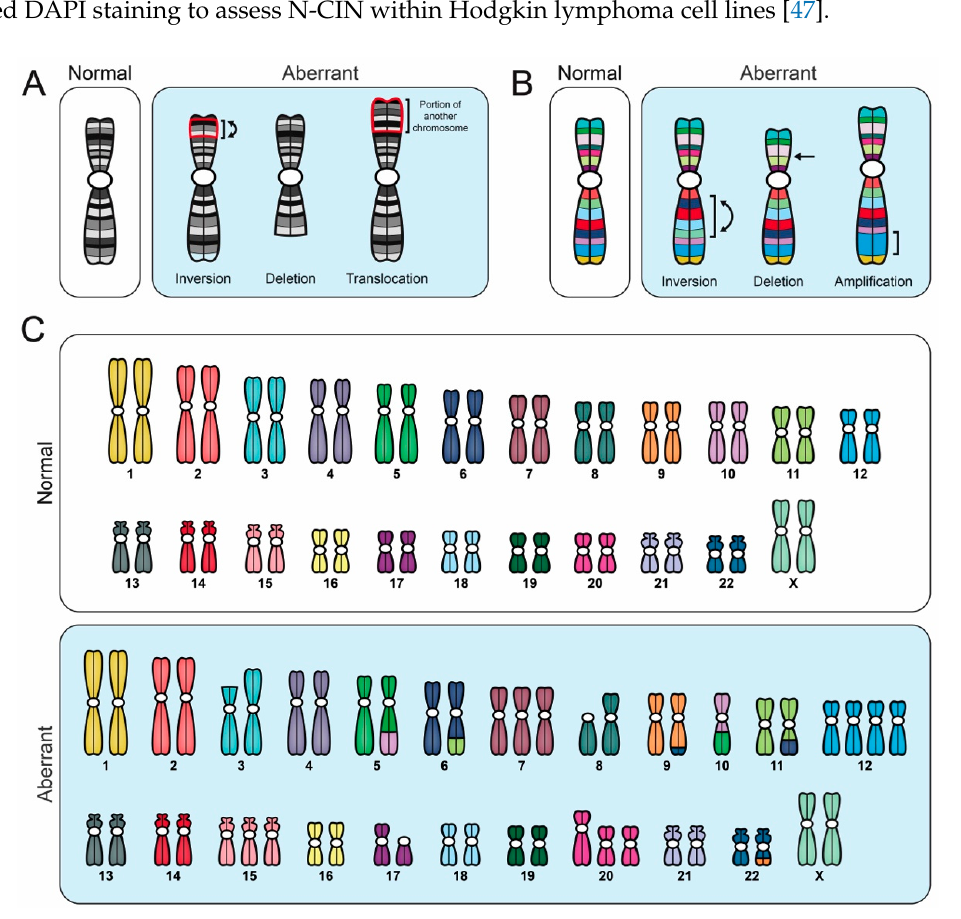
Figure 3. Comparison of different cytogenetic techniques used to evaluate CIN. Schematic